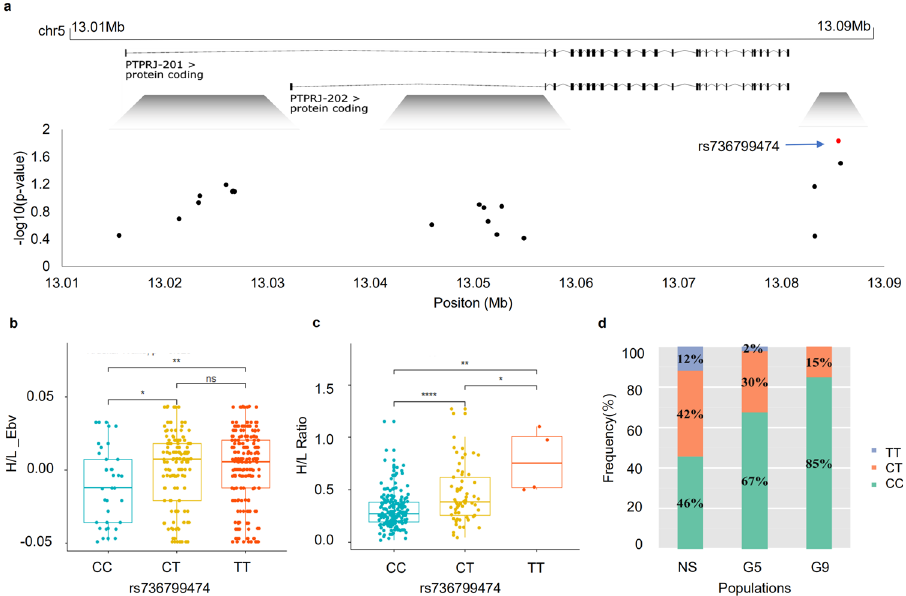
Fig. 6 Identi fi cation of the universal SNP associated with chicken H/L (rs736799474). a and b Effects of rs736799474 alleles in JLH chickens. Genome annotation according to chicken reference genome (ftp://ftp.ensembl.org/pub/release-96/fasta/gallus_gallus/dna/). c Effects of rs736799474 alleles in the H/L selection population. d Allele distributions in the selection line and non-selection JXH chickens. Middle line represents the median, upper and lower limits of box represent the upper and lower quartiles in bar